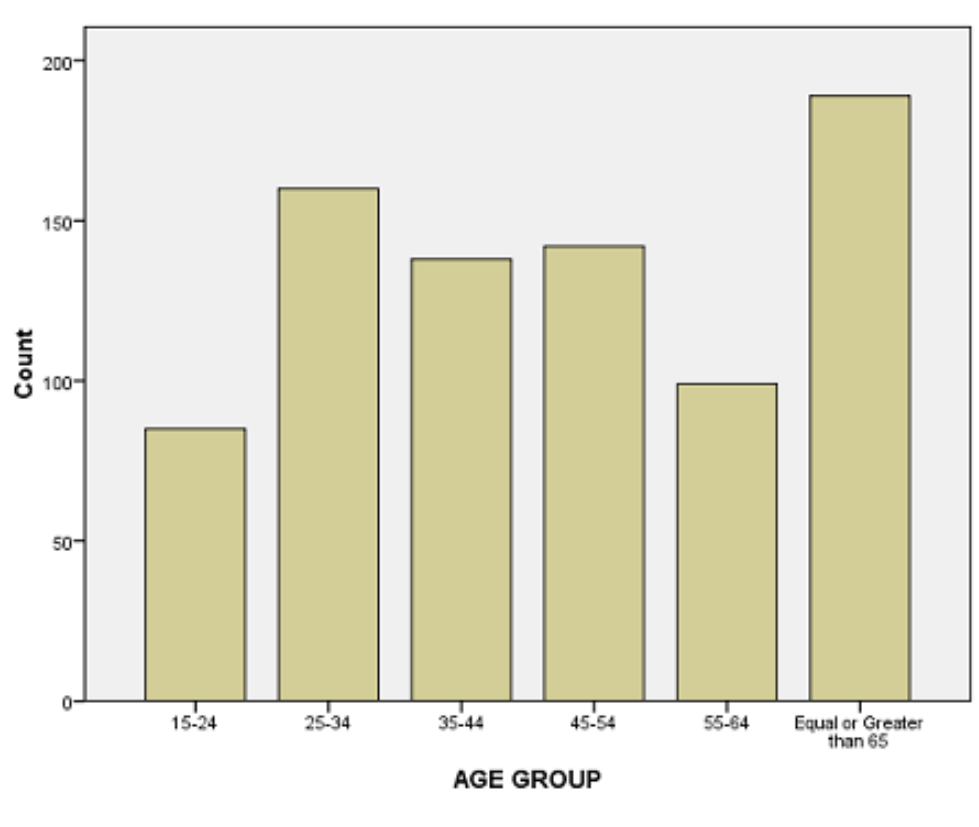
Figure 1: Age group distribution of the study